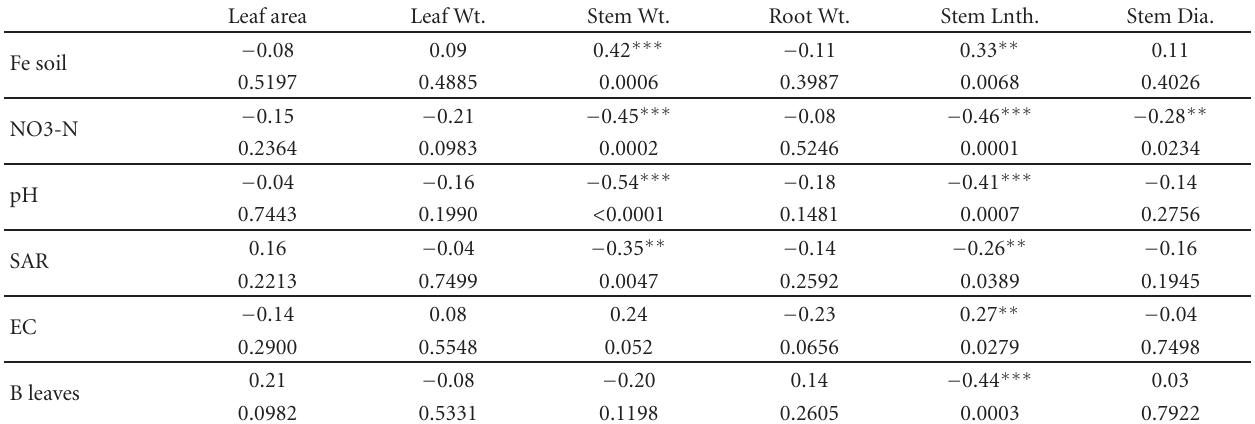
Table 4: Correlation matrix for 2005 Greenhouse Study showing growth versus soil and foliar parameter. Note: correlation coe ffi cients ( r values) are followed by P values; ∗∗ indicates significance P < . 05; ∗∗∗ indicates significance P < . 001.